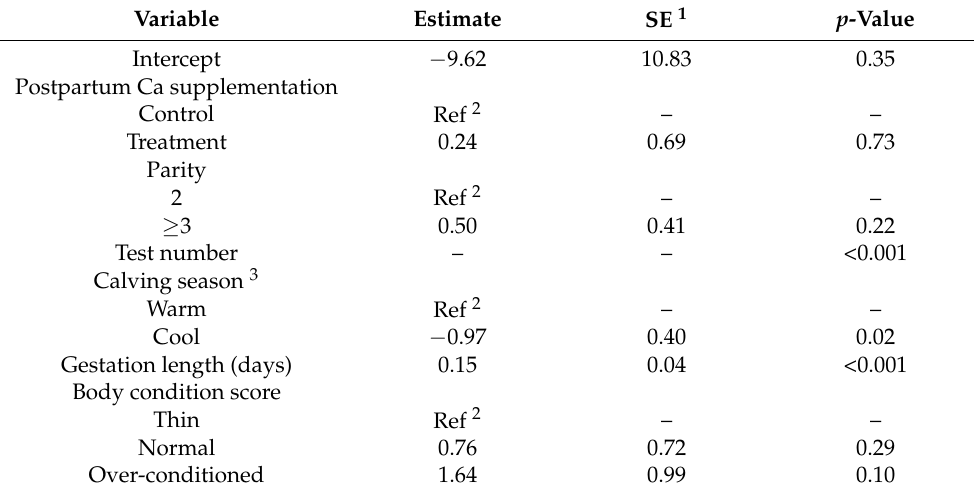
Table 5. Final linear mixed model evaluating the effect of an oral postpartum calcium supplemen- tation strategy with milk production within 15 weeks of lactation in a randomized clinical trial in multiparous Jersey cows ( n = 809) in a dairy in west